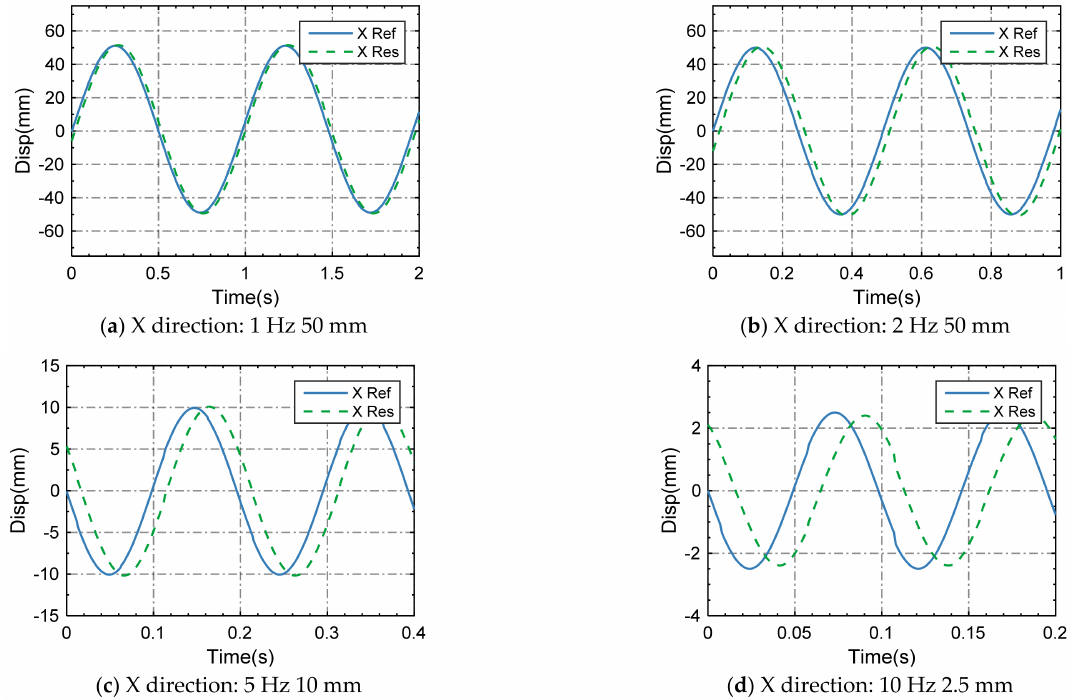
Figure 8. Experiment Result of Sinusoidal along X